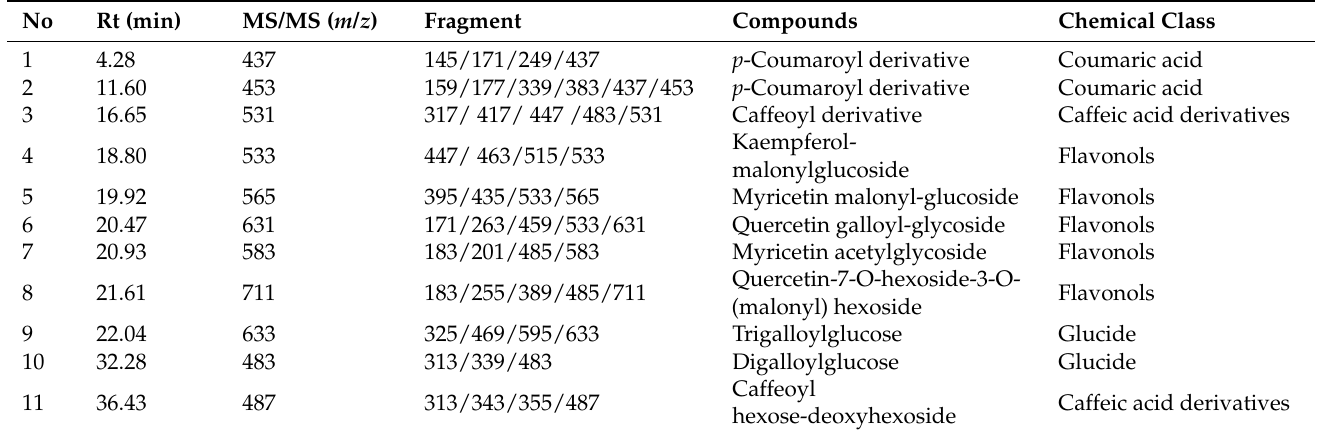
Table 5. Identification of phenolic compounds of J. regia leaves extracts using HPLC-DAD-ESI-